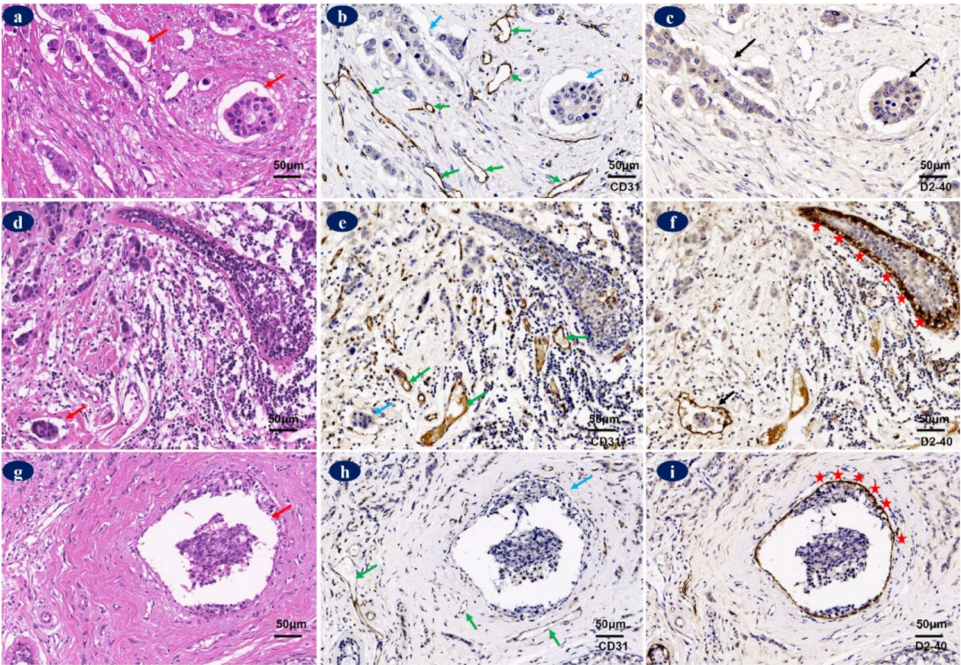
Figure 5. D2-40/CD31 immunohistochemistry staining was utilized to distinguish between lymphatic vessel invasion (LVI) and clefts, blood vessels invasion, or ductal carcinoma in situ in breast cancer tissues. ( a ) Clefts in HE (red arrows). ( b ) CD31-negative clefts (blue arrows) and CD31-positive blood vessels (green arrows). ( c ) D2-40-negative clefts (black arrows). ( d ) LVI in HE staining (red arrow). ( e ) Discontinuous CD31-positive LVI (blue arrow) and continuous CD31-positive blood vessels (green arrows). ( f ) Continuous D2-40-positive LVI (black arrow) and D2-40-positive myoepithelial cells (red stars). ( g ) Ductal carcinoma in situ (DCIS) in HE staining (red arrow). ( h ) CD31-negative DCIS (blue arrow) and CD31-positive blood vessels (green arrows). ( i ) D2-40-positive myoepithelial layer of the DCIS (red stars). (200 × ). Protocols for HE and immunohistochemistry stainings were stated